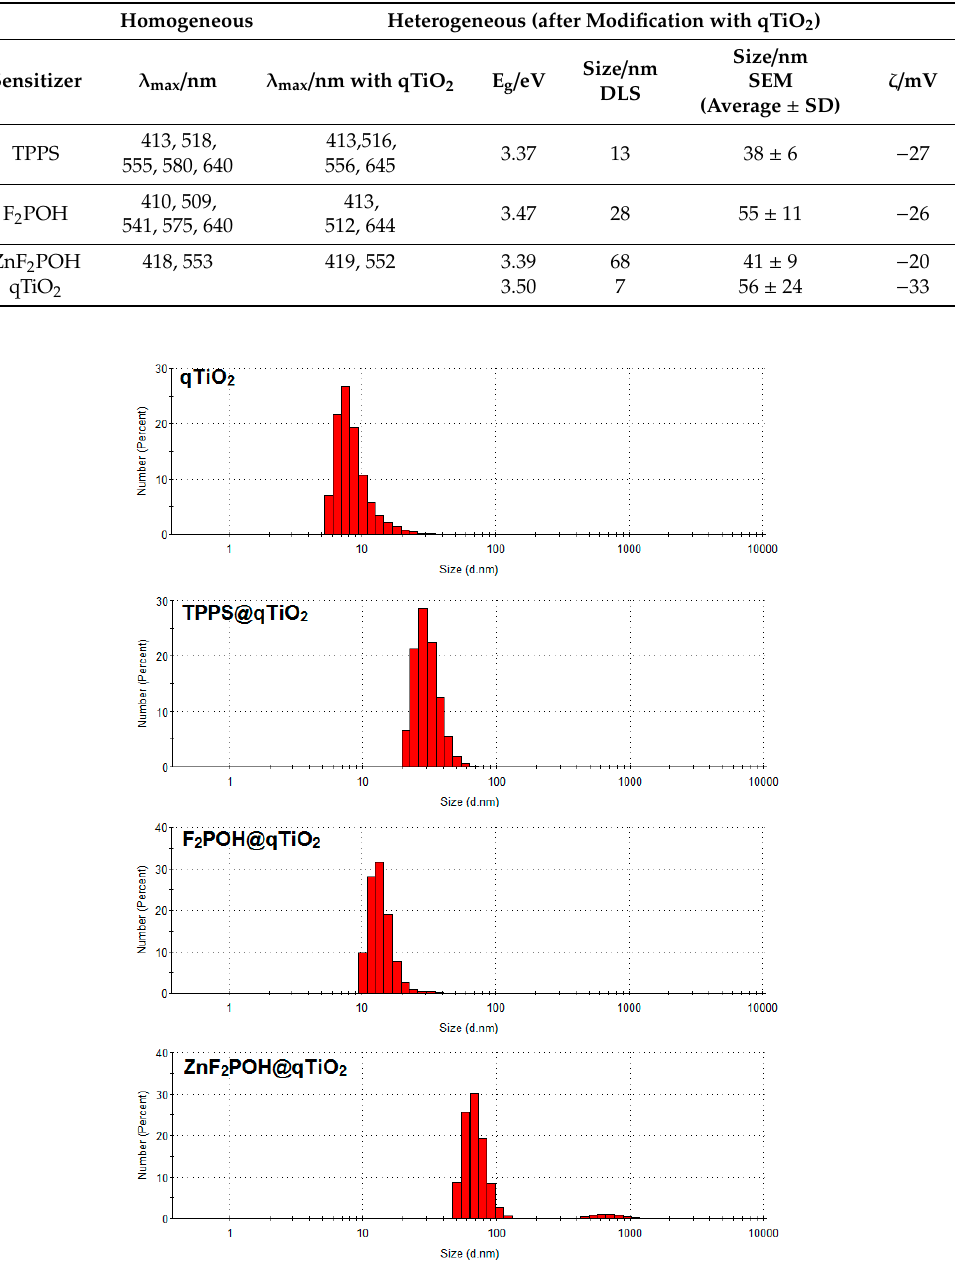
Figure 2. Size distribution of nanocrystalline materials in the aqueous solution.